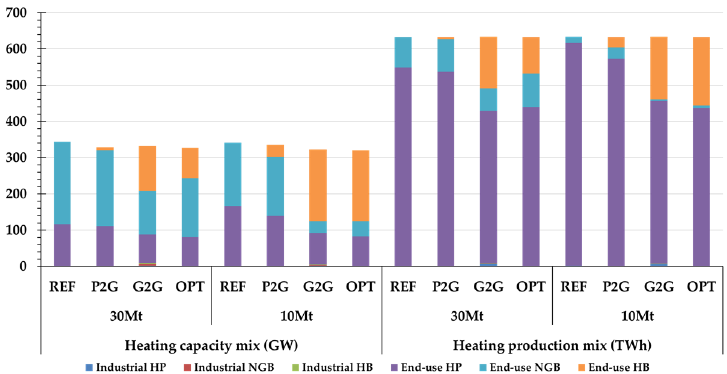
Figure 6. Heating technology capacity and production portfolio under different carbon targets.